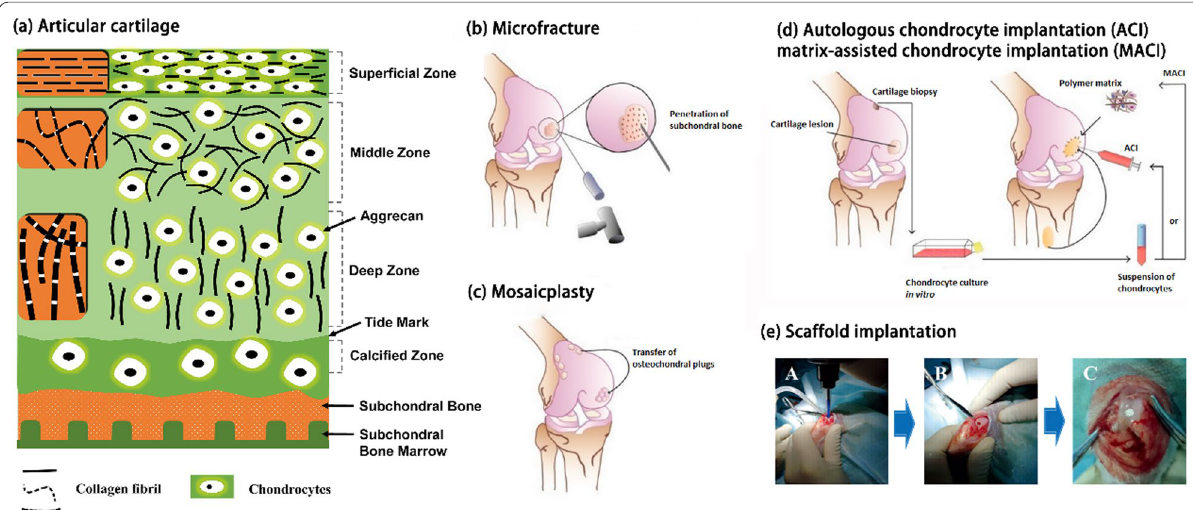
Fig. 1 General structure of cartilage and well-accepted therapy strategies for cartilage defect repair. a Diagrammatic representation of highly-organized articular cartilage from human adult with special features. The layered structures are distinguished by chondrocytes morphology, collagen fibrils arrangements, specific biomarkers and characteristic structure are indicated. b - d Non-biomaterials-based therapy strategies involved in cartilage defect, microfracture, mosaicplasty, autologous chondrocyte (ACI) implantation and matrix-assisted chondrocyte implantation (MACI). Microfracture provides an enriched environment for stimulating tissue regeneration via releasing bone marrow. Mosaicplasty is conducted by patching up the articular cartilage defects with the low weight-bearing areas from articular joint. ACI and MACI are carried out through injecting pre-harvested autologous chondrocytes into the cartilage defect. MACI incorporates chondrocytes into 3D collagen scaffold while ACI performs the in vitro amplification in liquid medium. (Adapted from ref. [3], copyright 2020, with permission from the Elsevier.) e Process of biomaterials-based therapy via implantation. (Adapted from ref. [21], copyright 2020, with permission from the